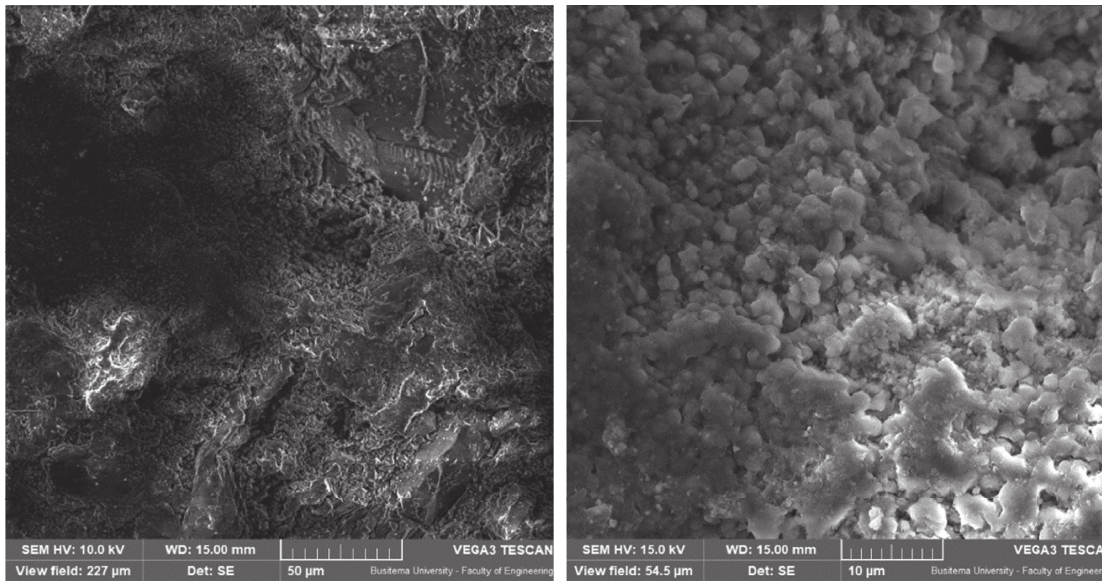
Figure 12: SEM morphology for plain concrete.